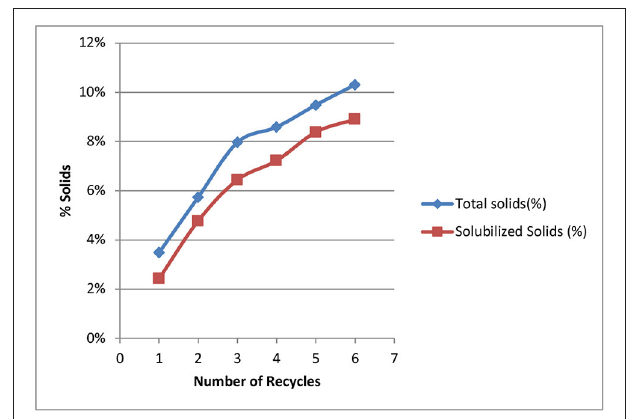
FIGURE 3 | Effect of number of recycling on total solids and soluble solids in the recycled black